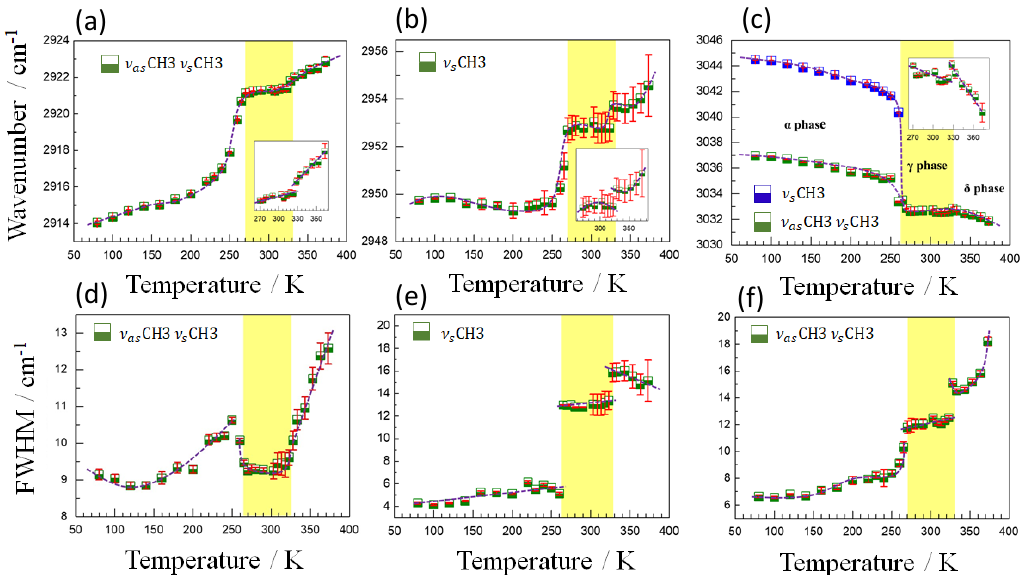
Figure 8. Temperature dependence of the wavenumber ( a – c ) and FWHM ( d – f ) of the most representative modes in the region of higher frequencies. The half-filled blue and green squares represent experimental data and the solid dotted purple lines represent eye guidelines. The solid vertical lines in red indicate the calculation error bar. The insets ( a – c ) indicate details of the wavenumber behavior around the second structural phase transition.